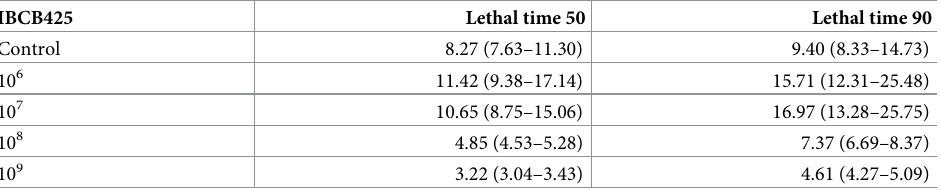
Table 2. Lethal times (50 and 90) of Metarhizium anisopliae (IBCB425) (days) with different concentrations (conidia/mL) in the mortality of Thaumastocoris peregrinus third instar nymphs and adults (Hemiptera: